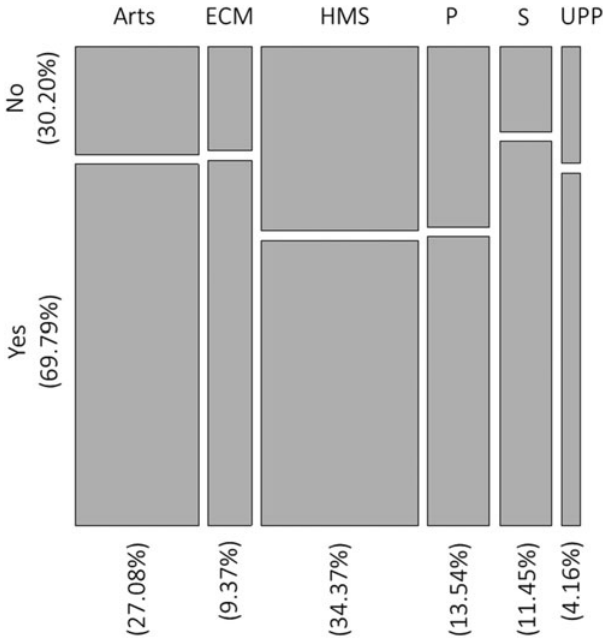
Fig. 5. Mosaic plot representing associations between categorical variables of inter- est. The mosaic plot shows the marginal percentages in each faculty (preventing per- forming [multiple] pairwise comparisons). ECM, Faculty of Engineering, Computer, and Mathematical Sciences; HMS, Faculty of Health and Medical Sciences; P, Faculty of Professions; S, Faculty of Science; UPP, University Preparatory